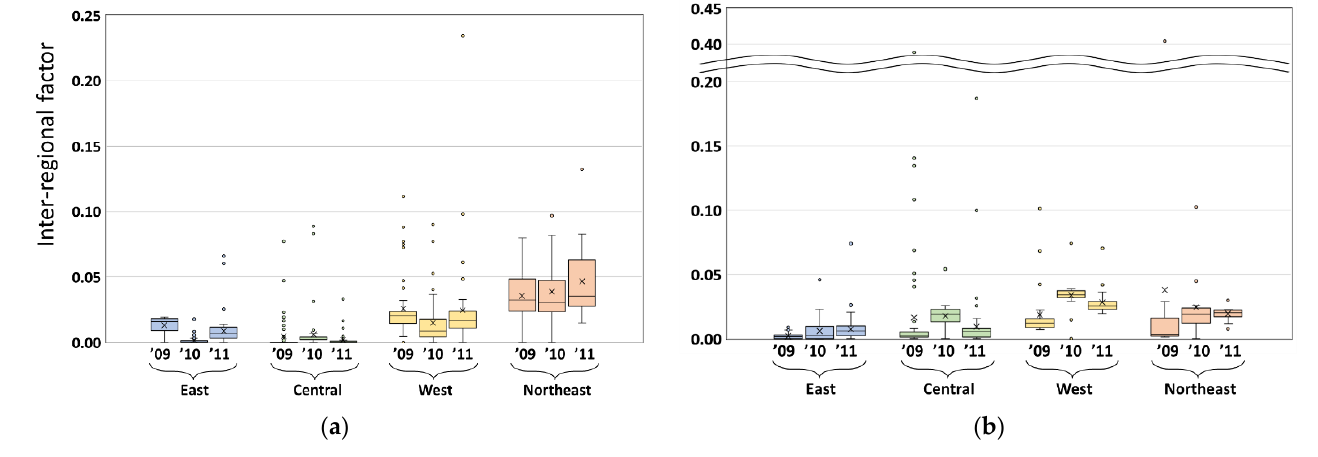
Figure 5. Boxplots of inter-regional factor in ( a ) the SM group and ( b ) the LARGE group by year and region. ’09, ’10, and ’11 refer to the years 2009, 2010, and 2011, respectively. “×” and “°” stand for the average value and outliers, respectively.